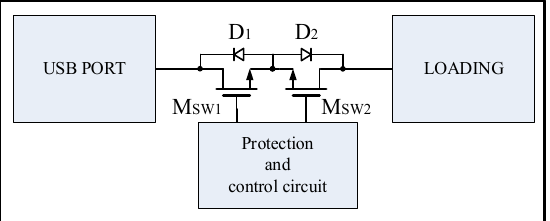
Figure 1. Schematic diagram of the USB interface protecting circuit.